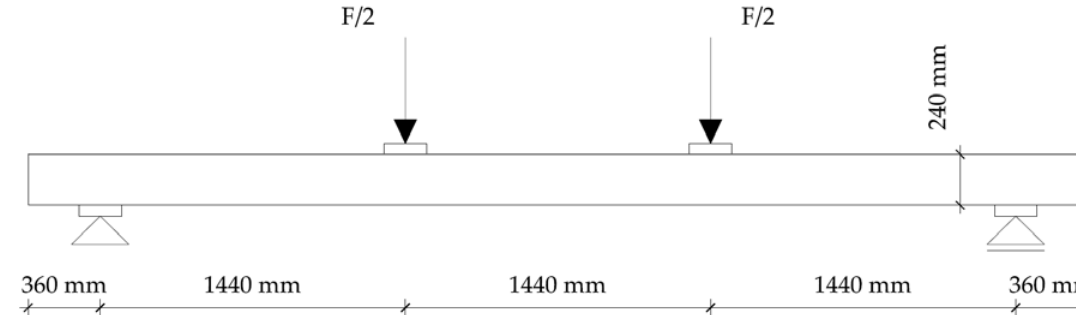
Figure 4. Test setup–4-point bending.